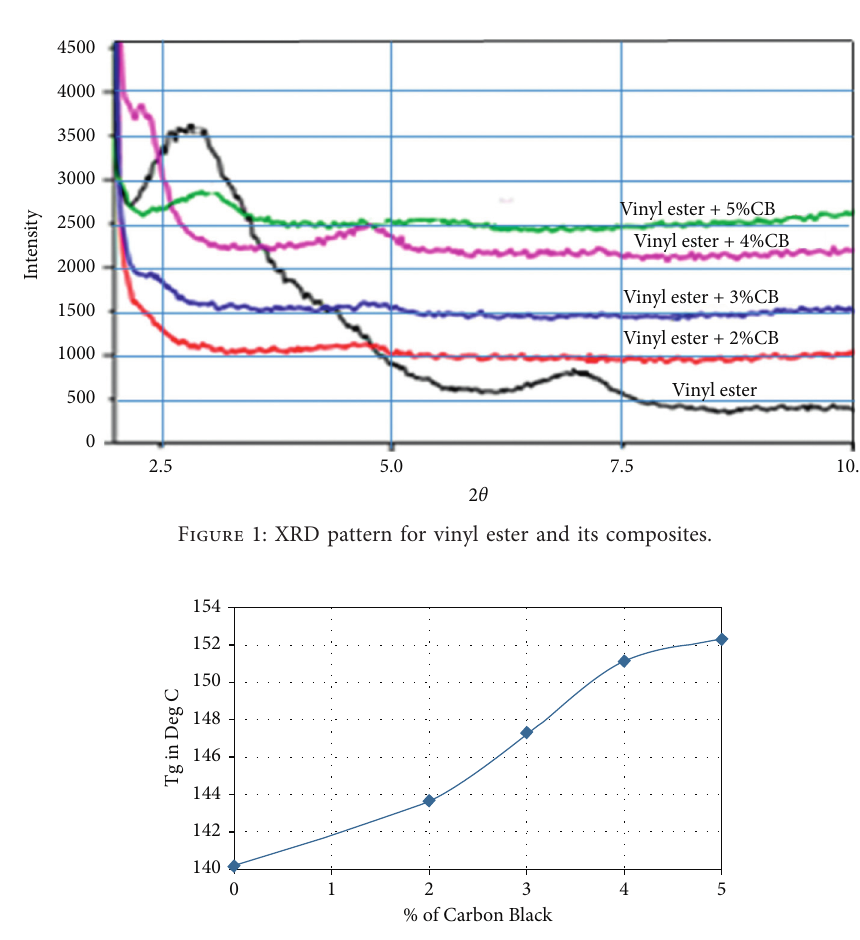
Figure 2: Effect of carbon black on Tg of the vinyl ester composites.